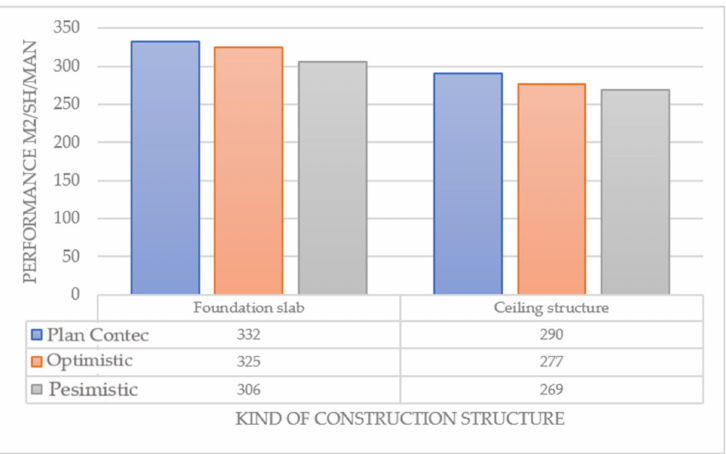
Figure 13. Productivity of ironworks.